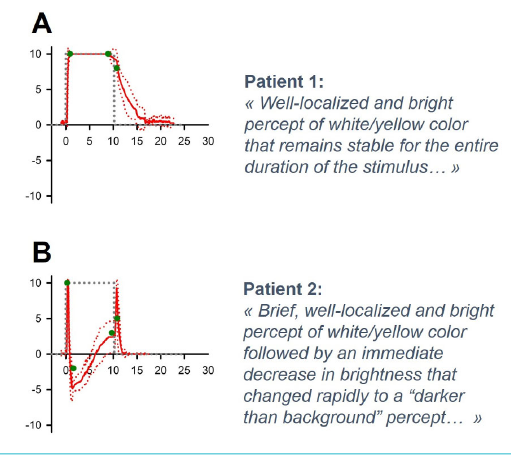
Figure 6: Time course of the percepts evoked upon electrical stimulation in two retinal implant recipients. The graph on the left presents the time course of the percept (red plot) upon a 10s duration, stimulus (dotted gray line). The corresponding verbal de- scriptions of the subjects are presented in the right panel. Repro- duced with permission of The Association for Research in Vision and Ophthalmology, Inc. from: Pérez Fornos A, Sommerhalder J, da Cruz L, Sahel JA, Mohand-Said S, Hafezi F, Pelizzone M. Tem- poral properties of visual perception on electrical stimulation of the retina. Invest Ophthalmol Vis Sci. 2012;53(6):2720-31, permission conveyed through Copyright Clearance Center,